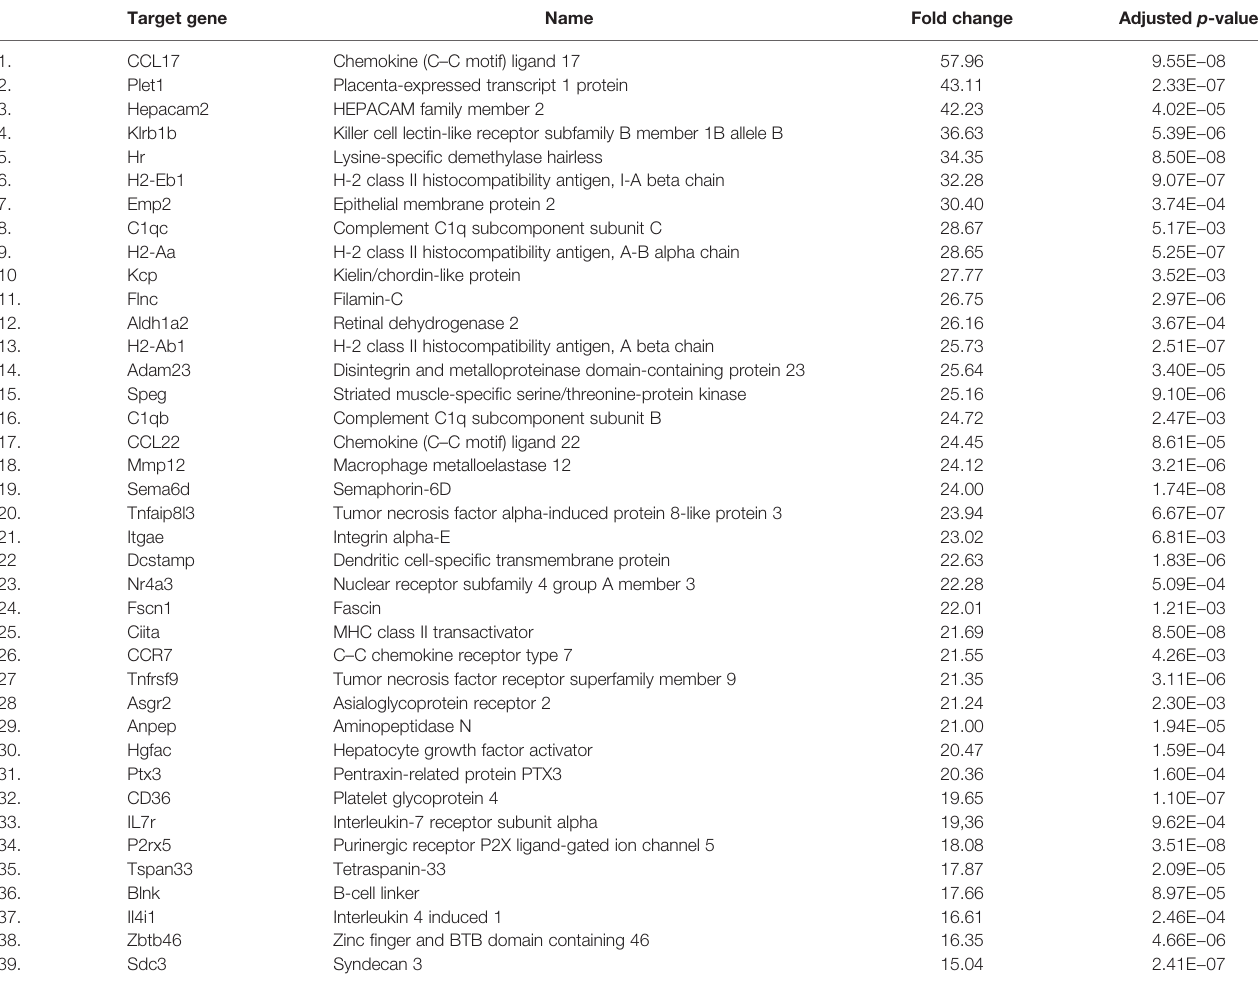
TABLE 3 | Most strongly upregulated genes (>15-fold increase) in CD11b+CD11c+ MDSCs compared with CD11b+CD11c −